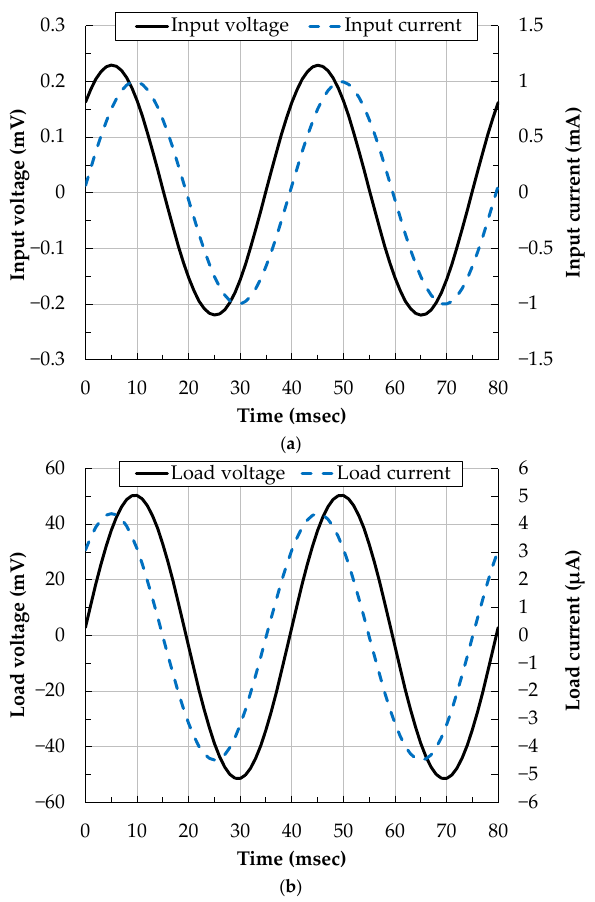
Figure 18. Optimized voltage and current waveforms at the input ( a ) and load ( b ) of gyrator excited with 1 mA current amplitude.